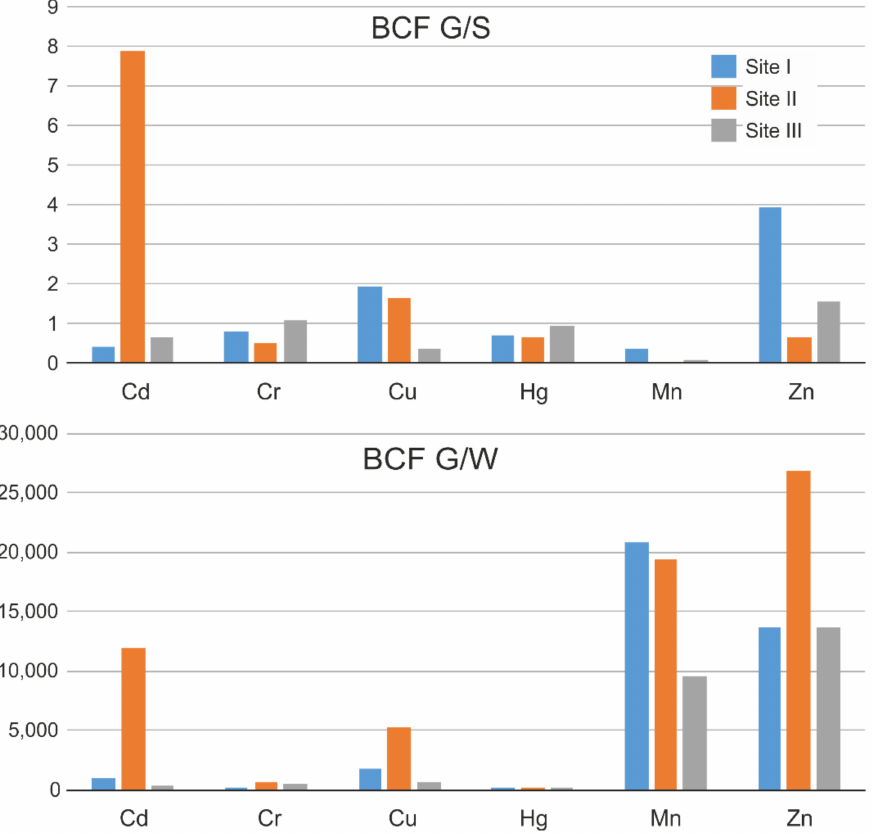
Figure 3. The bioconcentration factor (BCF) values of studied elements in G. densa with respect to the metal concentration in the substrate, where G means concentration of studied elements in G. densa ; S—in sediments, W—in